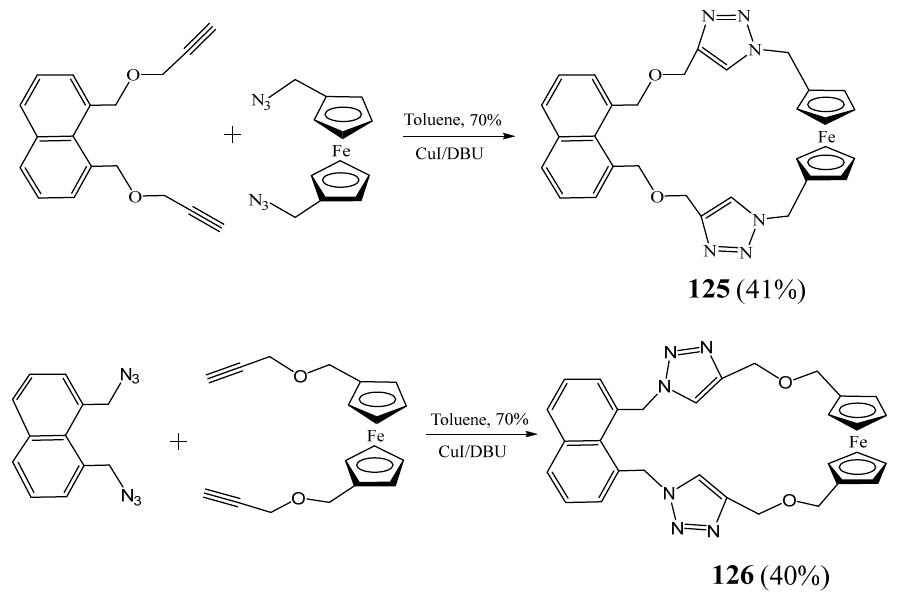
Figure 31. Ferrocene-containing macrocyclic triazoles 125 and 126. (Reprinted with permission from ref. [52]. Copyright 2016 Elsevier).